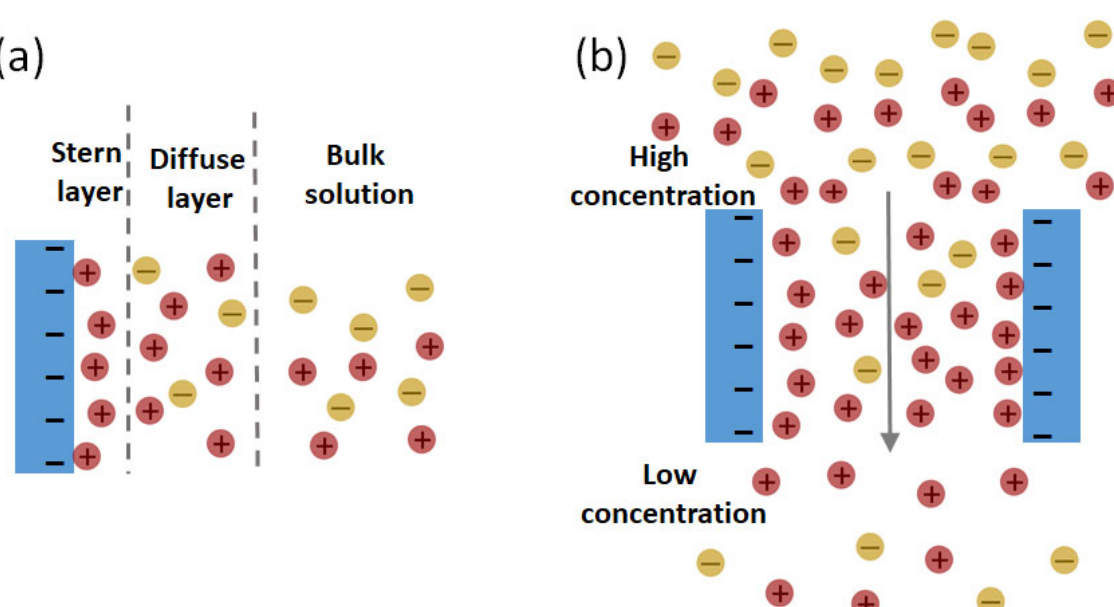
Figure 2. Schematic representation of ( a ) an electrical double layer at a negatively charged surface, ( b ) an overlapped electrical double layer inside a negatively charged pore.